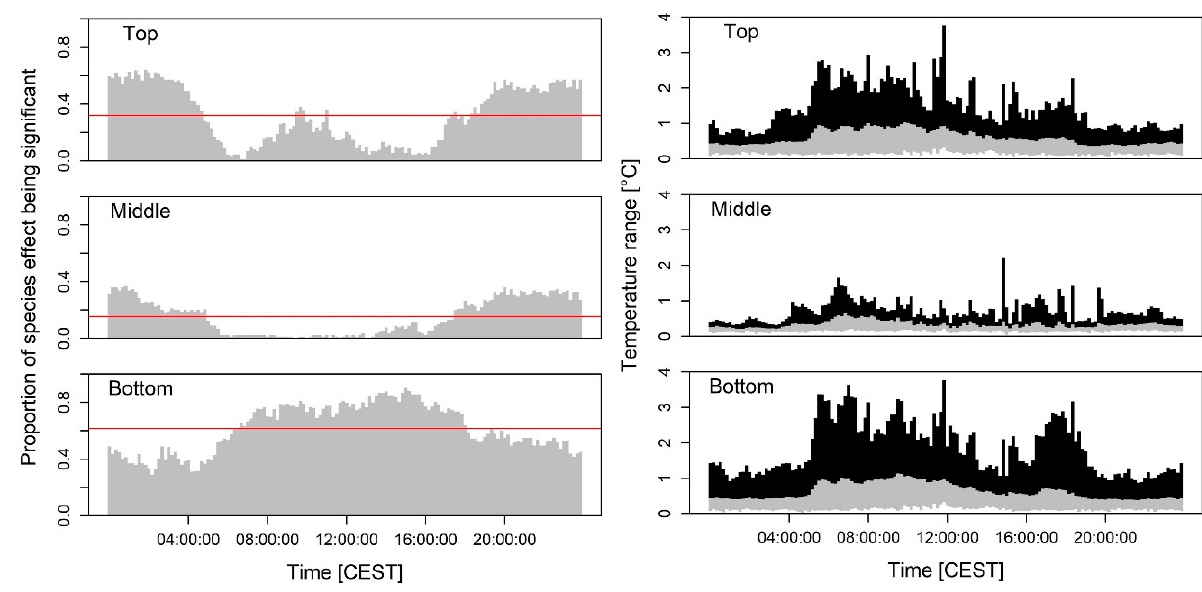
Figure 3. Aggregated model results analyzing tree species effects for the 13,248 single 10-min intervals between 1 July and 30 September in 2016. Proportion of significant species effects on air temperature for top, middle, and bottom sensor positions (left; red lines indicate the mean probability over all single time steps), as well as the temperature range between tree species with highest and lowest air temperatures (right; black indicates maximum, grey the mean, and white the minimum range for each time interval).